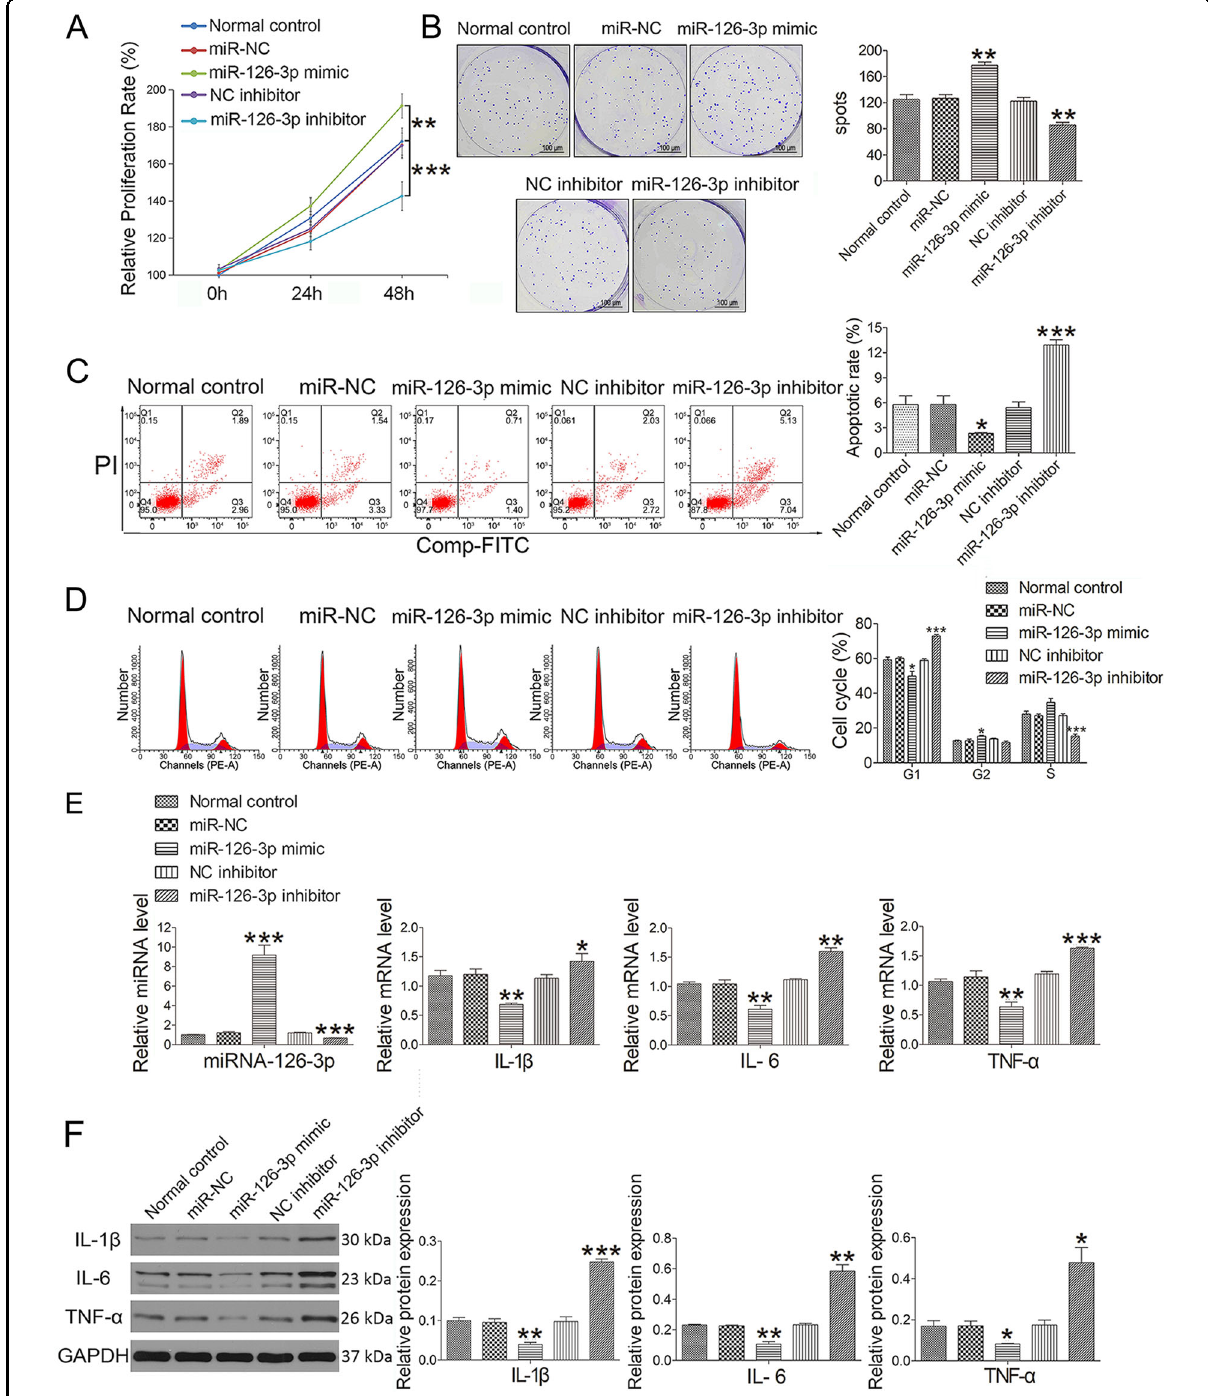
Fig. 2 Effect of miR-126-3p administration on chondrocytes. A Cell proliferation was determined by CCK-8 at concentrations of 100 pM (miRNA- 126-3p mimic and inhibitor) for 24 and 48 h. B The colony formation assay was used to analyze the effect of miRNA-126-3p mimic (100 pM) and miRNA-126-3p inhibitor (100 pM) on the proliferation of chondrocytes. C Apoptotic index was determined using fl ow cytometry in the presence of miR-126-3p mimic (100 pM) or inhibitor (100pM) constructs for 24 h. D Effect of miR-126-3p on cell cycle progression in the presence of miR-126-3p mimic (100 pM) or inhibitor (100pM) constructs for 24 h. E The miRNA (IL-1 β , IL-6, and TNF- α ) and mRNA (miRNA-126-3p) expression was detected by qRT-PCR in the presence of miR-126-3p mimic (100pM) or inhibitor (100 pM) constructs for 24 h. F Western blot assay was used to detect in fl ammation-related proteins (IL-1 β , IL-6, and TNF- α ) in the presence of miR-126-3p mimic (100pM) or inhibitor (100 pM) constructs for 24 h. Data were expressed as mean ± SEM ( n = 3). * P < 0.05, ** P < 0.01, and *** P < 0.001 vs. normal